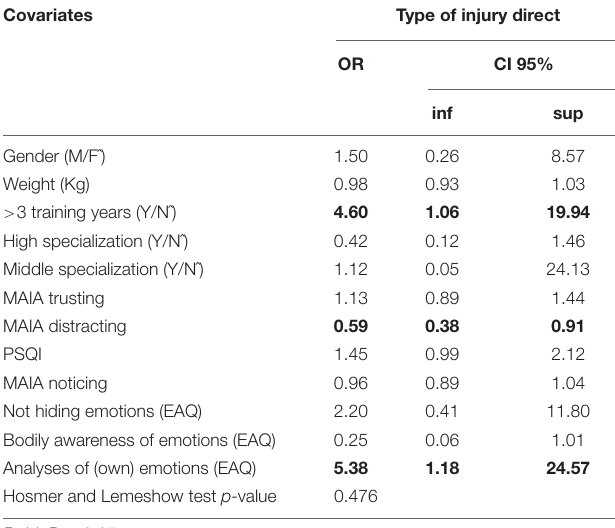
TABLE 3B | Regression model of “Rest from sports for injury”. Covariates